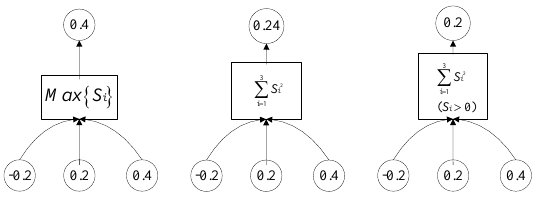
Fig.2. Flowchart of image attention analysis